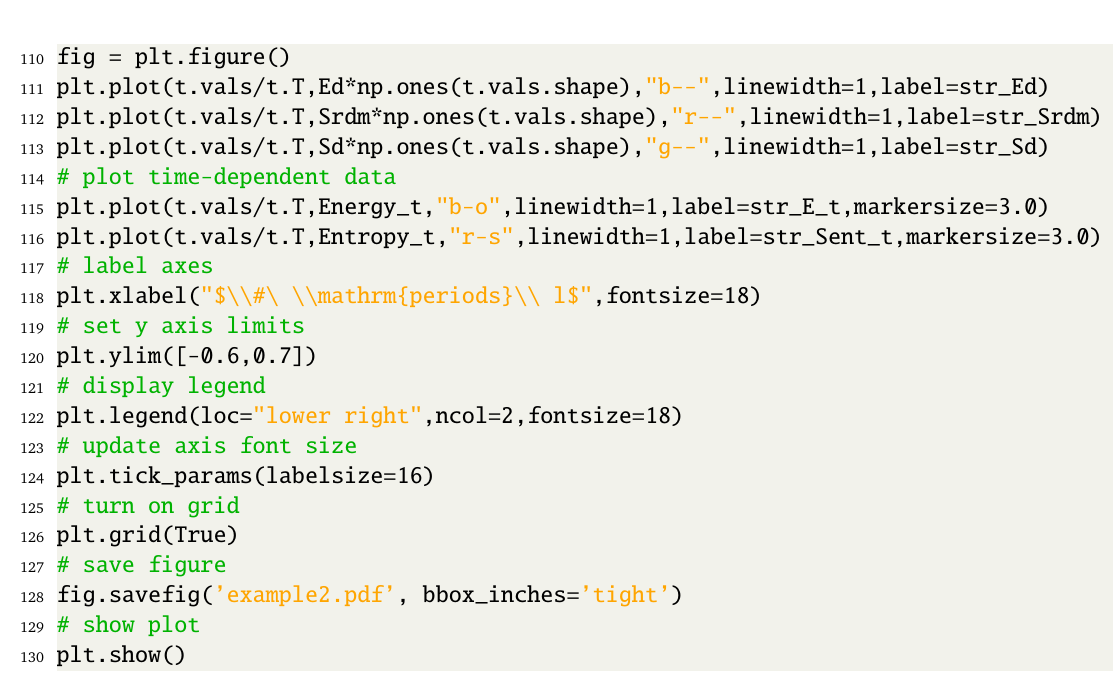
110 fig = plt.figure() 111 plt.plot(t.vals/t.T,Ed*np.ones(t.vals.shape),"b--",linewidth=1,label=str_Ed) 112 plt.plot(t.vals/t.T,Srdm*np.ones(t.vals.shape),"r--",linewidth=1,label=str_Srdm) 113 plt.plot(t.vals/t.T,Sd*np.ones(t.vals.shape),"g--",linewidth=1,label=str_Sd)